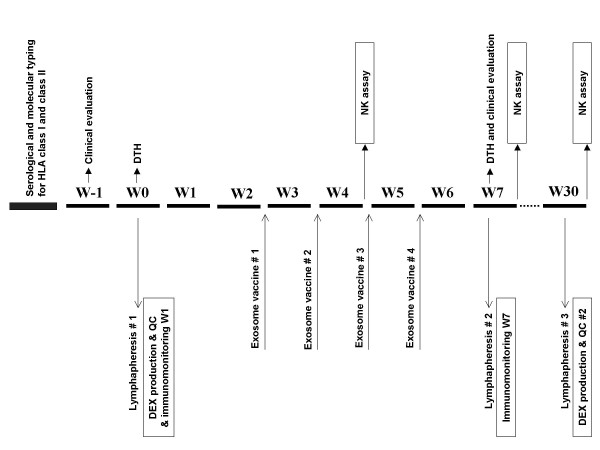
Schema of exosome purification processes. Exosomes were purified from monocyte derived-DC (MD-DC) culture supernatants according to a good manufacturing process already described [26]. In the second part of the trial, indirect loading of MHC class II peptides (MAGE3247–258.DP04, KKLLTQHFVQENYLEY) was performed on DC cultures followed, after exosome purification by a direct loading of MHC class I (MAGE3168–176.A1/B35; EVDPIGHLY) peptides at 10 or 100 μg/ml at pH 4.2 [22]. Quality control parameters included dosing of exosomal MHC class II molecules, flow cytometry analyses and functional assays using superantigens as described in material and methods.